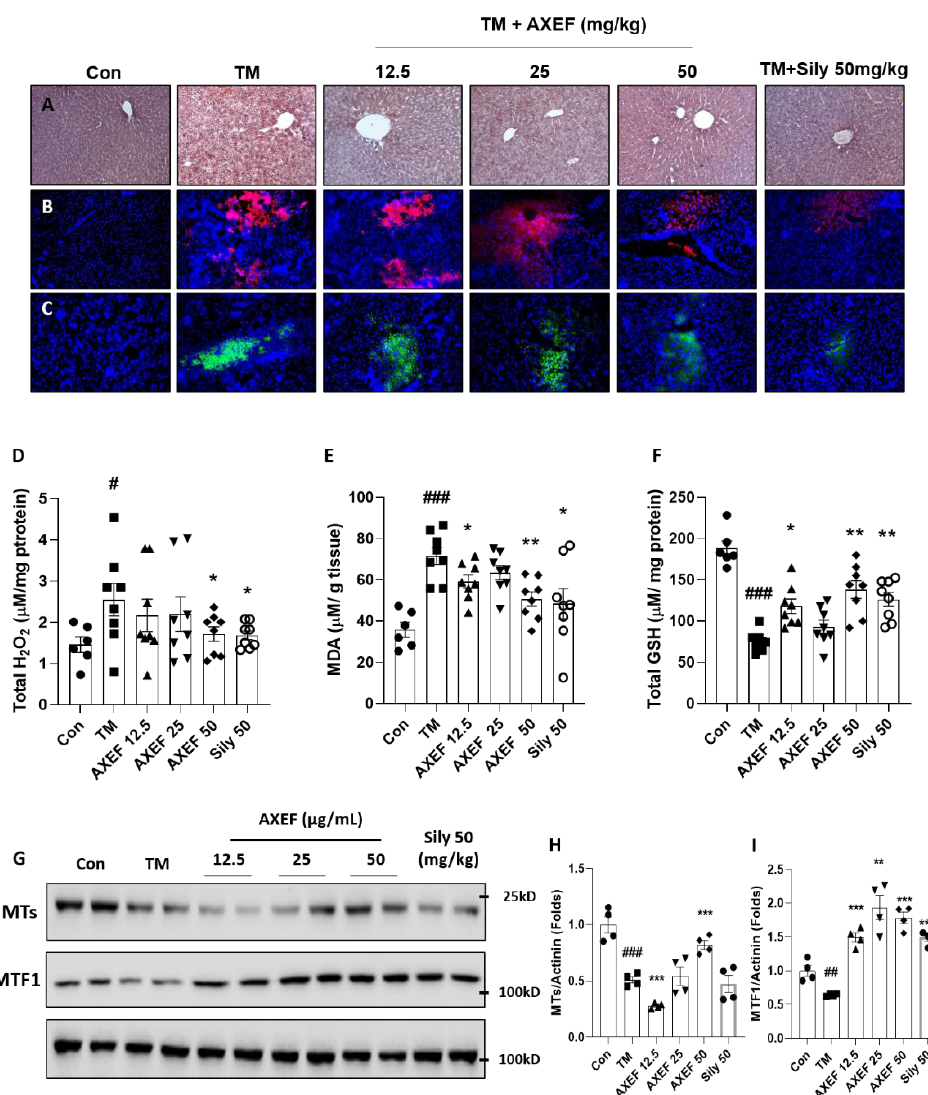
Figure 3. Antioxidant effects of AXEF on the ER stress-induced NASH mice model via improvement of hepatic MTs. ( A ) Immunohistochemistry analysis against 4-HNE, ( B ) fluorescence quenching analysis of DHE (red fluorescence), and ( C ) DCF-DA (green fluorescence). DAPI was used to counter stain the nucleus (Blue fluorescence). Hepatic protein levels of ( D ) H 2 O 2 , ( E ) MDA, and ( F ) GSH were measured. ( G ) Western blot analysis of hepatic protein levels of MT and MTF1. ( H,I ) Protein intensity levels of hepatic MT ( H ) and MTF1 ( I ) . Data are expressed as the mean ± SD (n = 3–4 for IHC analysis and hepatic ROS quenching analysis; n = 6–8 for each group for hepatic H 2 O 2 , MDA, and total GSH levels; n = 4 for Western blot analysis, respectively). # p < 0.05; ## p < 0.01; ### p < 0.001 for the Con vs. TM, * p < 0.05; ** p < 0.01; *** p < 0.001 for TM vs. AXEF or Sily 50. Images were captured using light microscopy (200× magnification) or fluorescence filtered microscopy (200×